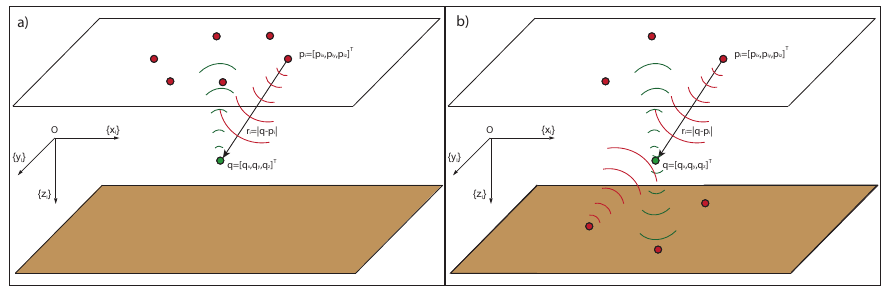
Figure 6. Sensor formations for an uncertainty volume of 60 × 60 × 60 m 3 ( a ) surface sensor network; and ( b ) sensor network split into two formations, one at the sea surface and another at the sea